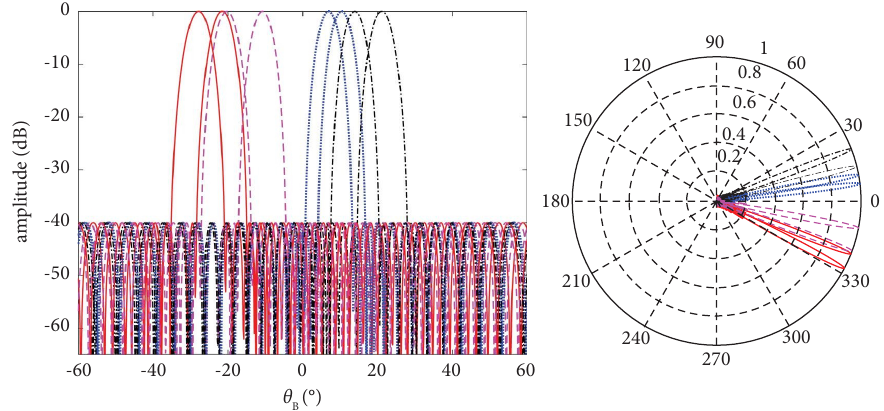
Figure 12: Defection of